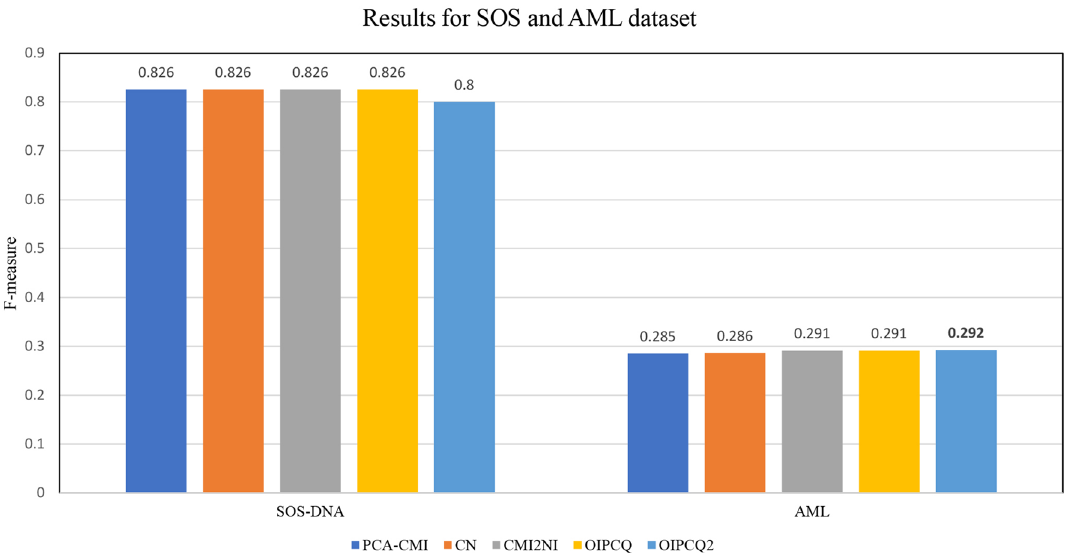
Figure 5. Comparison of F-measure values of OIPCQ and OIPCQ2 algorithms with other methods for learning SOS-DNA and AML.